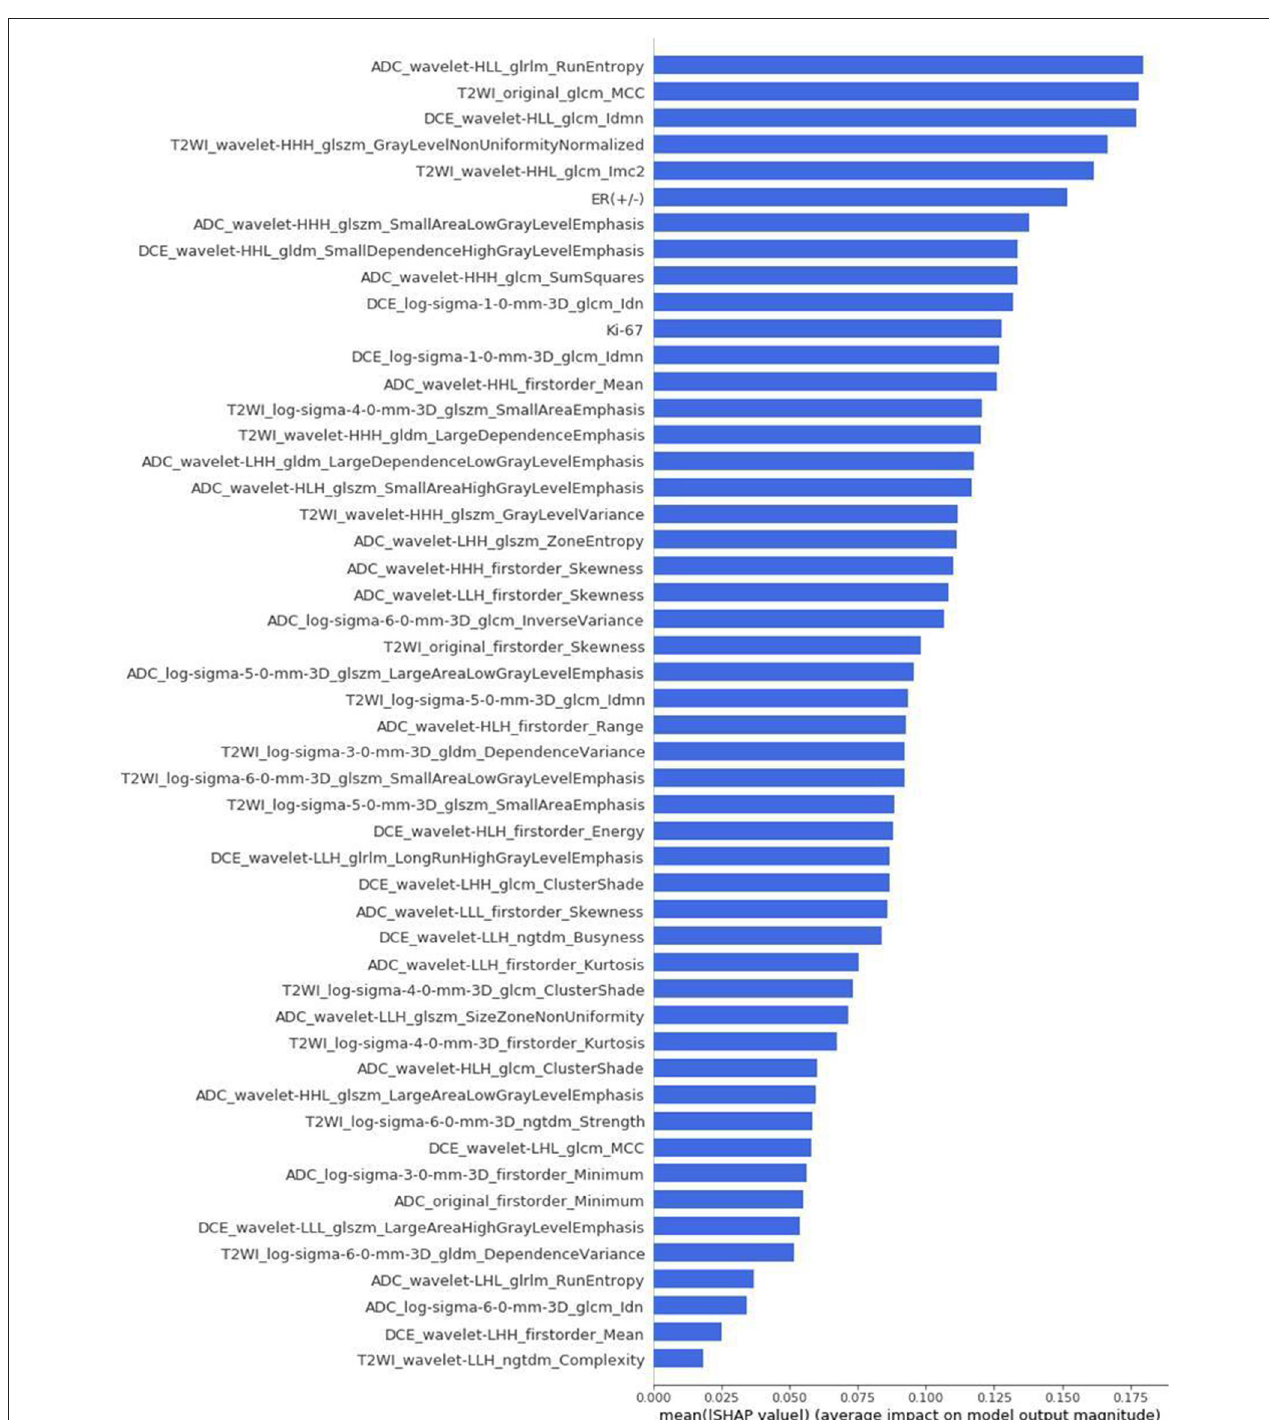
FIGURE 8 | The weight importance rank of selected features. The feature with a longer bar contributes more to the model.